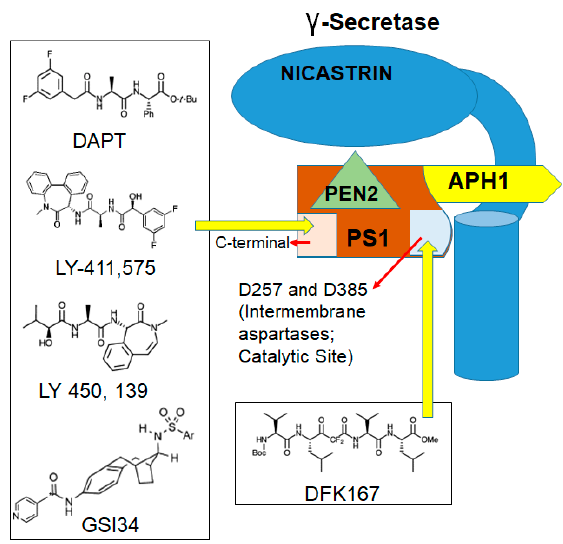
Figure 3. Model for the major events in the Notch signaling pathway: Signals initiated by the engagement of the ligand lead to metalloprotease (MP) cleavage at site S2. γ -Secretase complex cleaves Notch1 at the S3 site within the transmembrane domain. Intracellular Notch (NICD) is released from the membrane, translocates to the nucleus, and forms a complex with CSL and MAM.